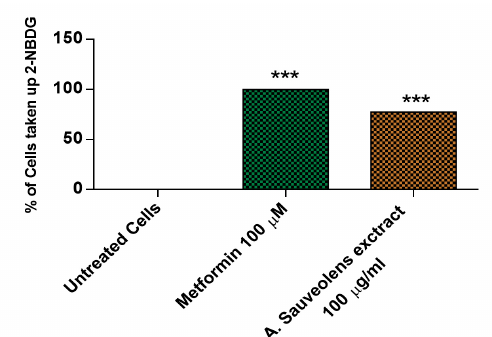
Fig. 9. The percentage of cells taken up 2-NBDG when treated with Metformin and test compound. Untreated cells are considered as negative